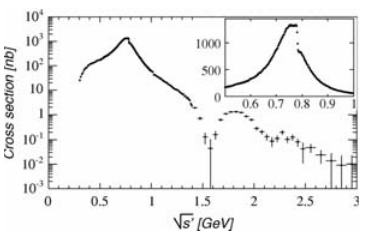
Figure 2. The e + e − → π + π − hadronic cross section at B A B AR . The spectrum is dominated by the ρ (770) resonance and interference between ρ and ω resonances can be observed in the peak region (the inset is a magnification of the peak). The other features at 1.6GeV and 2.2GeV are interpreted as the interference between ρ (cid:6) and ρ (cid:6)(cid:6) resonances, and an even higher mass ρ state, respectively.